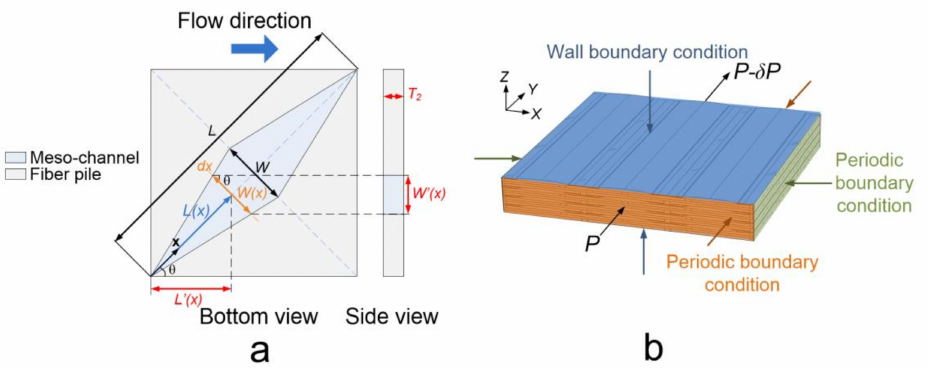
Figure 10. ( a ) Solution of the e ff ective permeability of a wedge-shaped channel which oriented θ from the flow direction ( θ = 45 ◦ ) ( b ) boundary conditions assigned in the unit cell model. Table 7. Intra-tow permeability and inter-tow permeability assigned in unit cell models. Unit Cells of Di ff erent